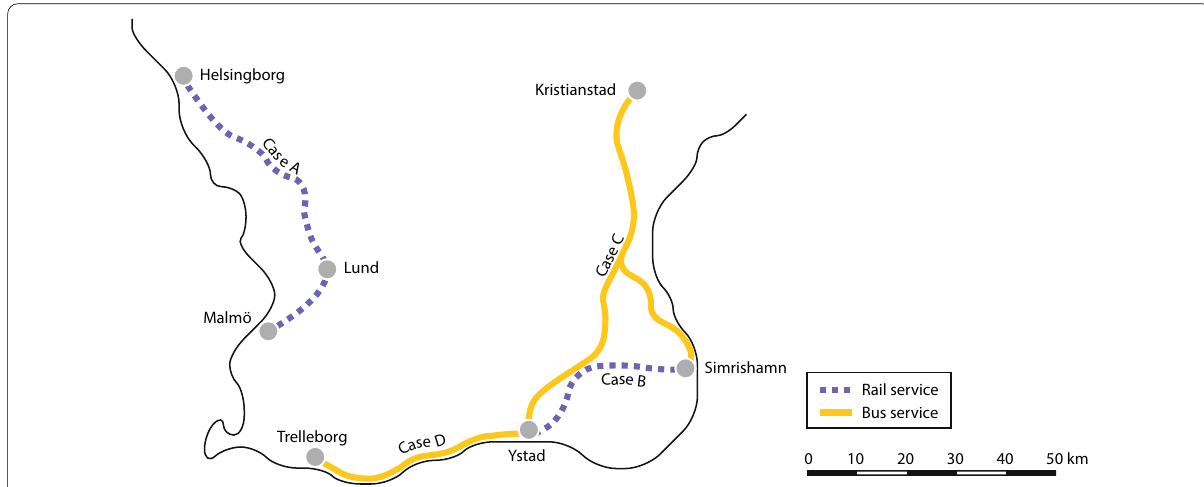
Fig. 1 Locations of the analysed cases in the region of Scania in southern